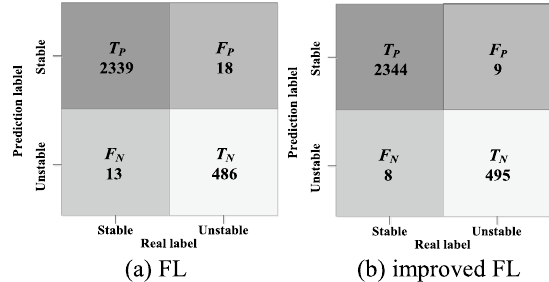
Fig. 9 TSA results on the test data set of the IEEE 39-bus system